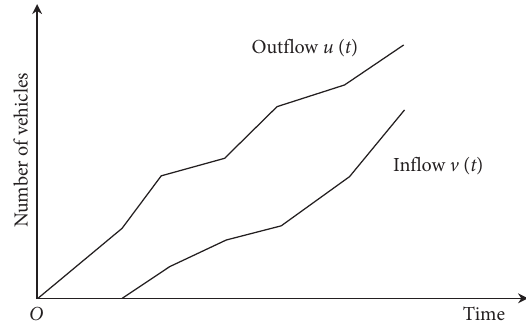
Figure 3: Schematic diagram of the inflow and outflow of vehicles on the road